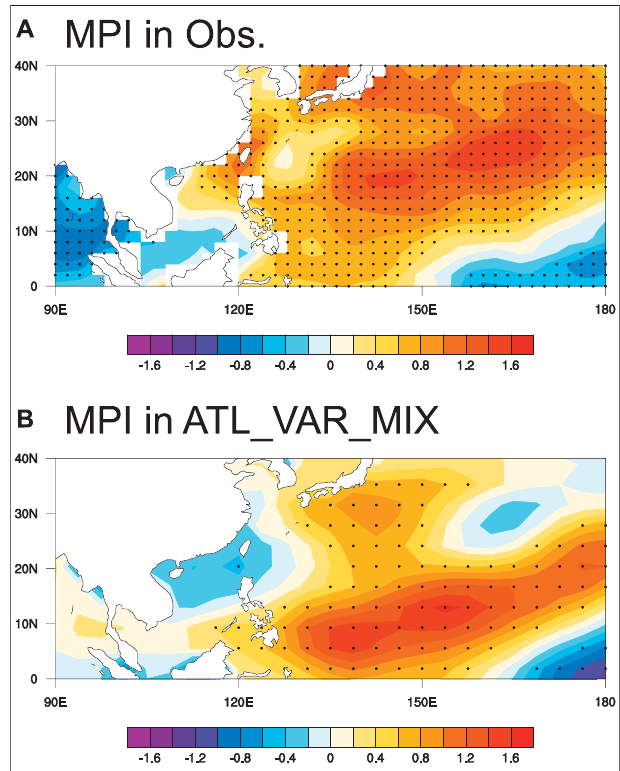
FIGURE 4 | The regression map of maximum potential intensity anomalies (m/s) onto the normalized AMO index based on the observational SST and 20CR atmospheric data for 1950 – 2010. (B) As in (A) , but in the ATL_VARMIX experiment. The long-term linear trends in the data were removed before the regression analysis, and dots indicate the regression coef fi cients signi fi cant at the 95% con fi dence level.